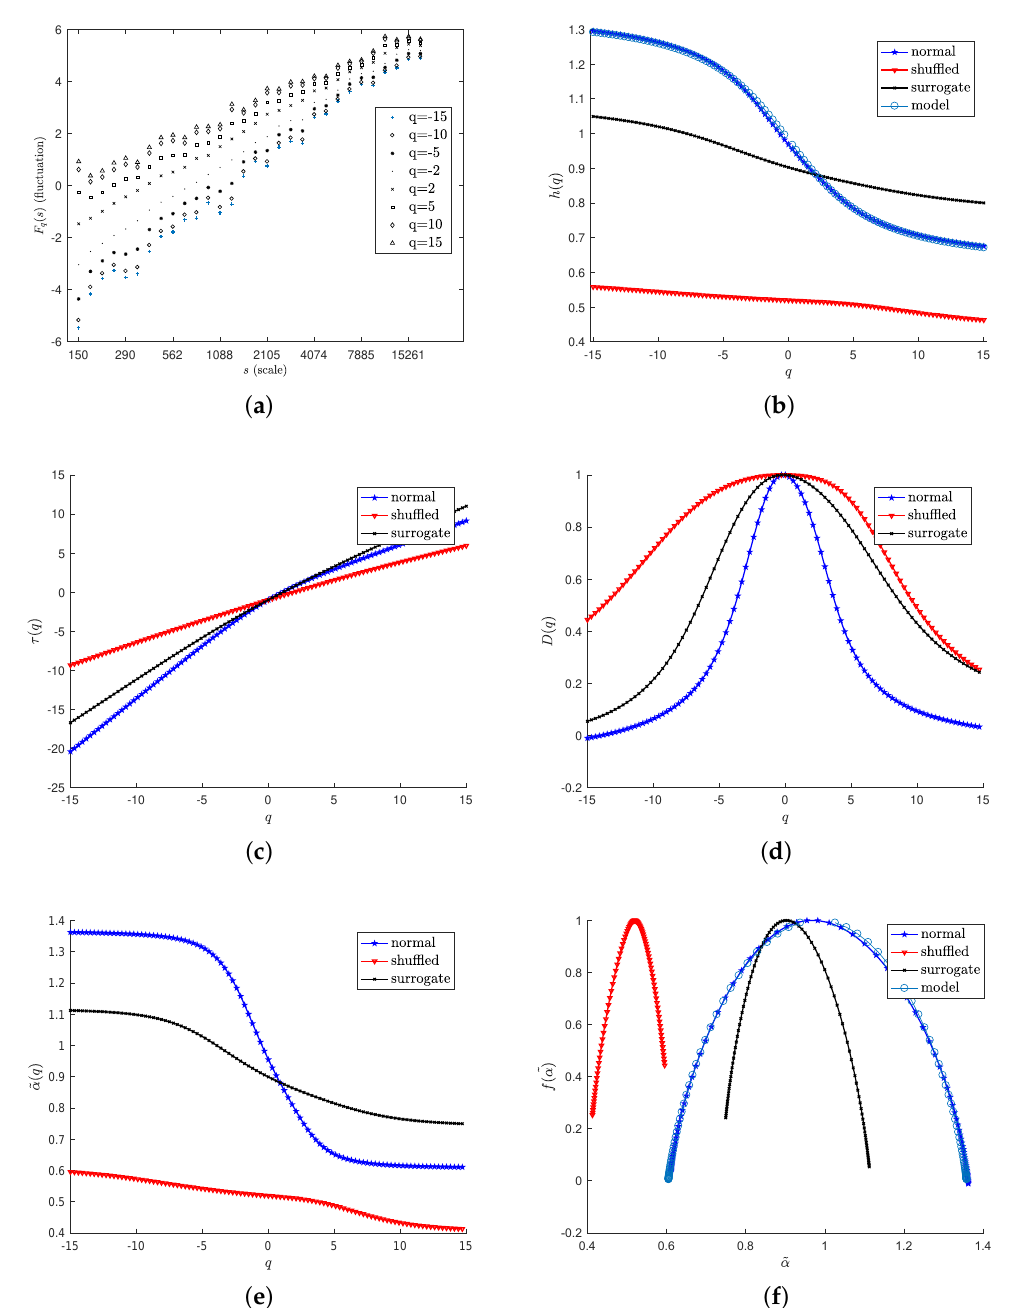
Figure 5. Results of the MFDFA3 on the BPd signal. Panel ( a ) reports the F q ( s ) vs. s diagram varying the timescale s in a wide range of values. Results of the MFDFA3 on the BPd signal for the original (normal), shuffled and surrogate time series. Panel ( b ) shows the h ( q ) vs. q diagram. Circles denotes the modified multiplicative model fitted to the data. Panels ( c – e ) report the mass exponent τ ( q ) vs. q , the generalized dimension D ( q ) vs. q and the Hölder exponent (cid:101) α ( q ) vs. q diagrams derived from the multifractal formalism. Panel ( f ) shows the multifractal spectrum for the BPd signal. The high amplitude ∆ of the multifractal spectrum together with the non-linear behavior of h ( q ) and τ ( q ) (cid:101) α demonstrate a strong multifractal signature of the analyzed signal. Shuffled and surrogate series indicate that the multifractality is due to long-range correlations. Finally, the near-optimal fitting of the modified multiplicative cascade model (A3), represented as circles in panels ( b ), shows that the BPd signal can be described concisely by only two parameters a and b